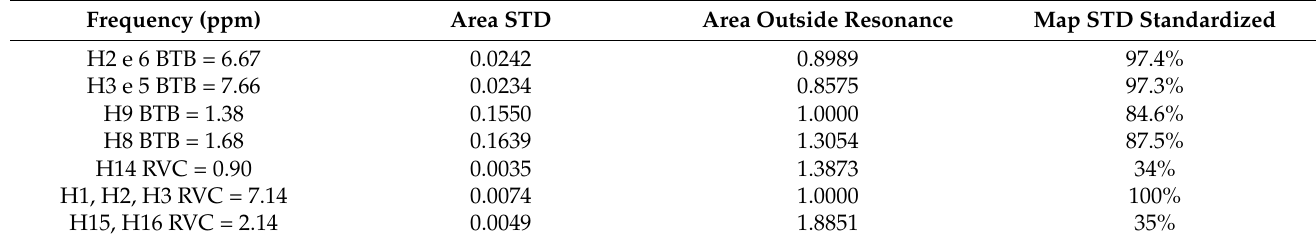
Table 3. Data obtained in the STD